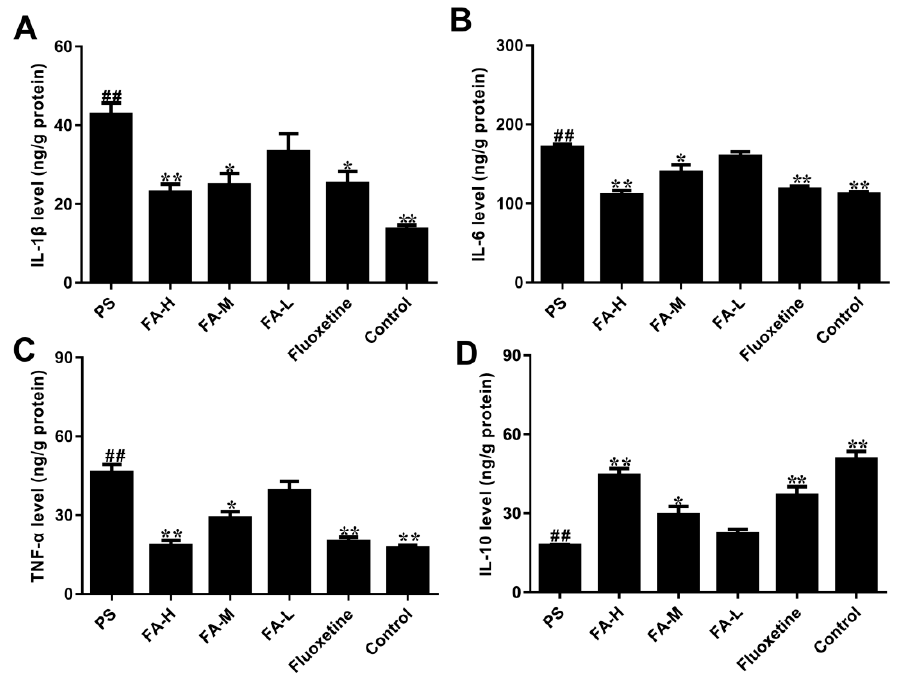
Figure 7. Effects of ferulic acid (FA) on the cytokine concentration in the hippocampus of offspring rats exposed to prenatal stress. ( A ) IL-1 β concentration in the hippocampus. ( B ) IL-6 concentration in the hippocampus. ( C ) TNF- α concentration in the hippocampus. ( D ) IL-10 concentration in the hippocampus. Values represent means ± SEM ( n = 8). * p < 0.05 and ** p < 0.01 compared with PS group, ## p < 0.01 compared with Control group. FA-L: FA at low 12.5 mg/kg/day, FA-M: FA at medium 25 mg/kg/day, FA-H: FA at high 50 mg/kg/day.